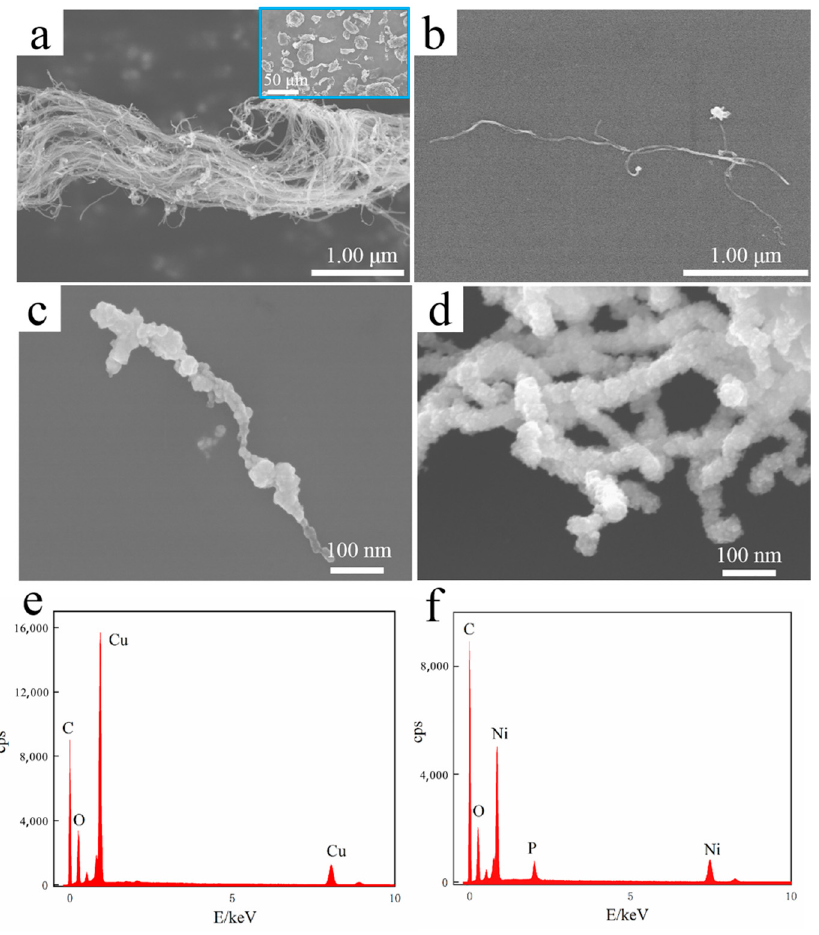
Figure 1. SEM micrographs of ( a ) original MWCNTs, ( b ) MWCNT after dispersion treatment, ( c ) Cu@MWCNTs, ( d ) Ni@MWCNTs, EDS of ( e ) Cu@MWCNT, ( f ) Ni@MWCNT. ( c ) Cu@MWCNTs, ( d ) Ni@MWCNTs, EDS of ( e ) Cu@MWCNT, ( f )